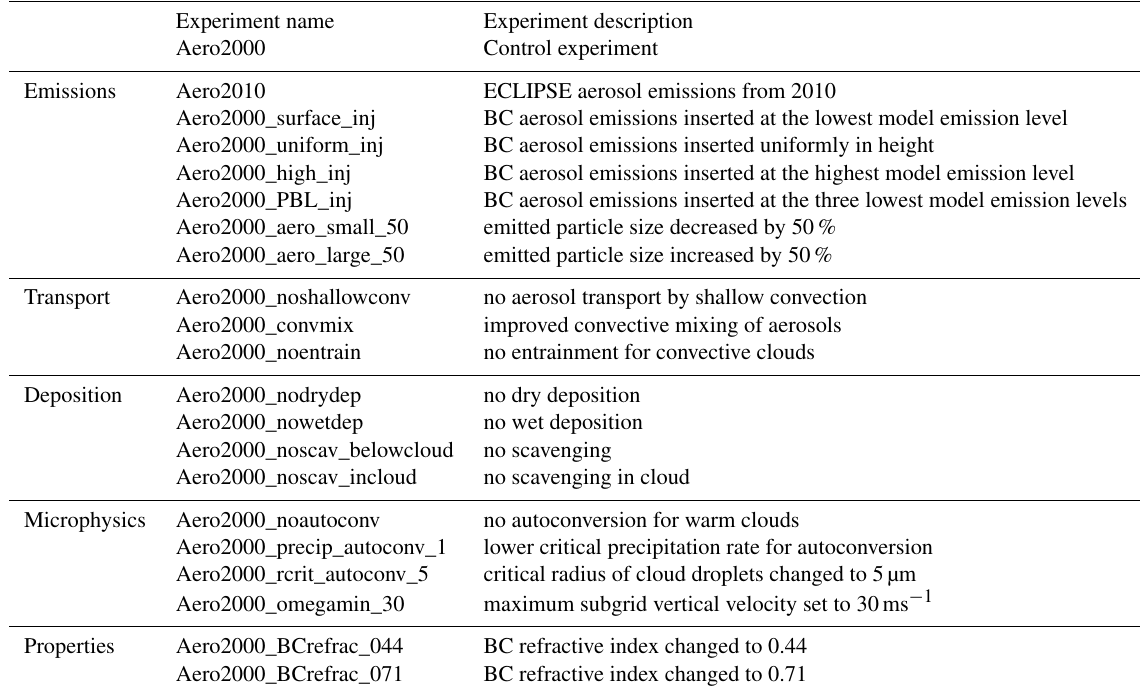
Table 1. Summary and short description of control and sensitivity